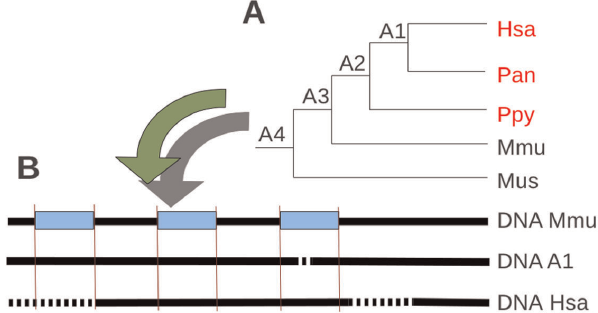
Figure 5. Example of processing sequences from a multiple sequences alignment and their ancestral sequences recon- structed. (A) Tree of species used for the reconstruction step. Species in red have sequence orthologs retrieved by GLADX. A1 , A2 , etc. correspond to ancestors reconstructed by Ortheus from orthologous sequences. Once this ancestral reconstruction is finished, the scan step is launched. (B) Sequences considered for an analysis at nucleotide level. Five scans will be carried out ( Hsa vs A1 , Pan vs A1 , Ppy vs A2 , A1 vs A2 , and A2 vs A3 ). Only Hsa against A1 is described here. The exon projection is necessary to each scan. Bold black lines are DNA, bold dotted lines are gaps, and red lines are projections from reference exons. Note that all abbreviations concerning species name and their ancestors are provided in Figure 6.